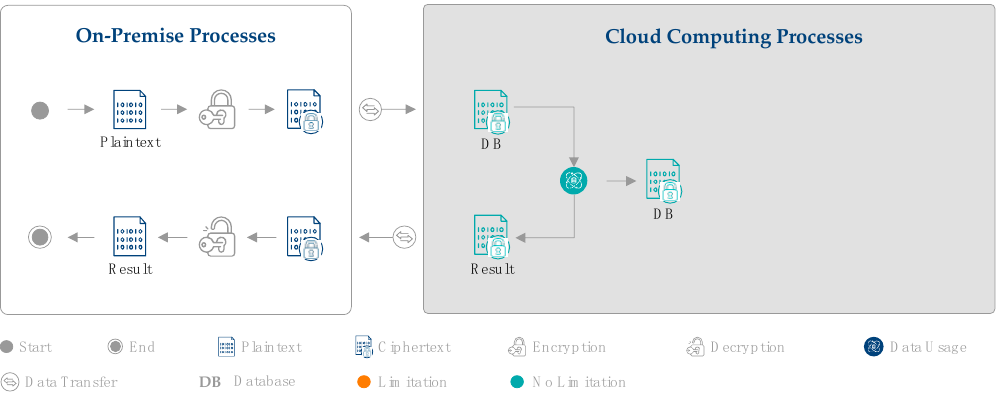
Figure 4. Potential of HE for cloud computing in production.